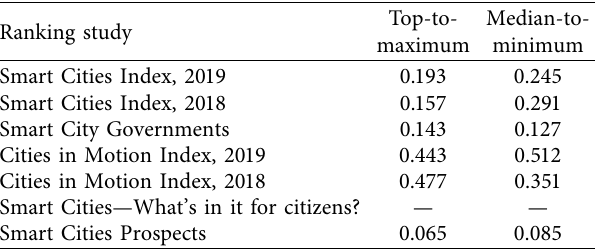
Table 9: Two measures of the spread of the normalized scores for the 7 ranking studies